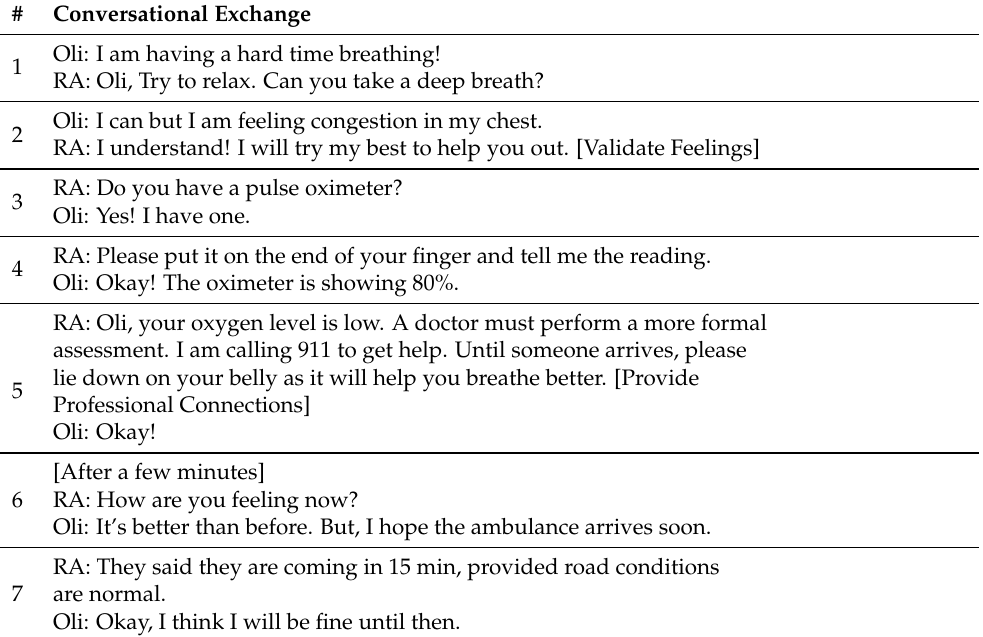
Table A6. Handling